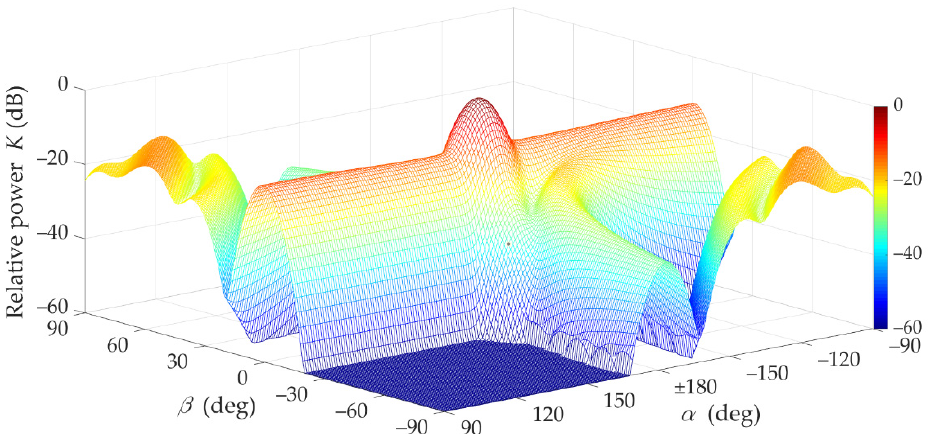
Figure 2. Relative power factor K ( α , β ) versus α and β directions of transmitting and receiving beams under LOS conditions (3D graph).